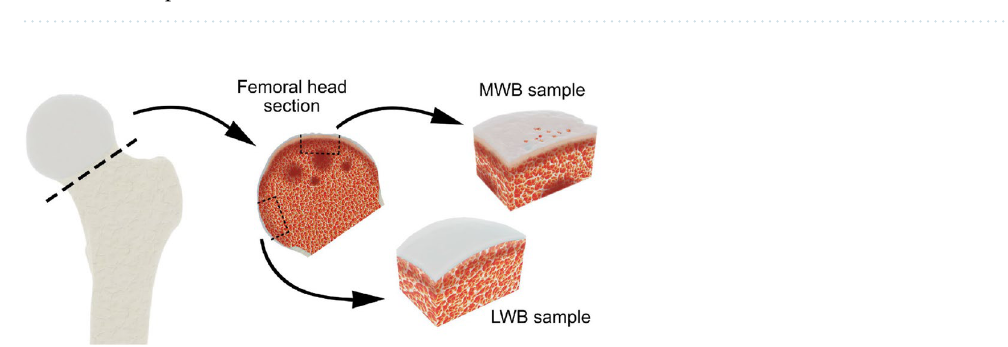
Table 1. Principle of inclusion and exclusion criteria.